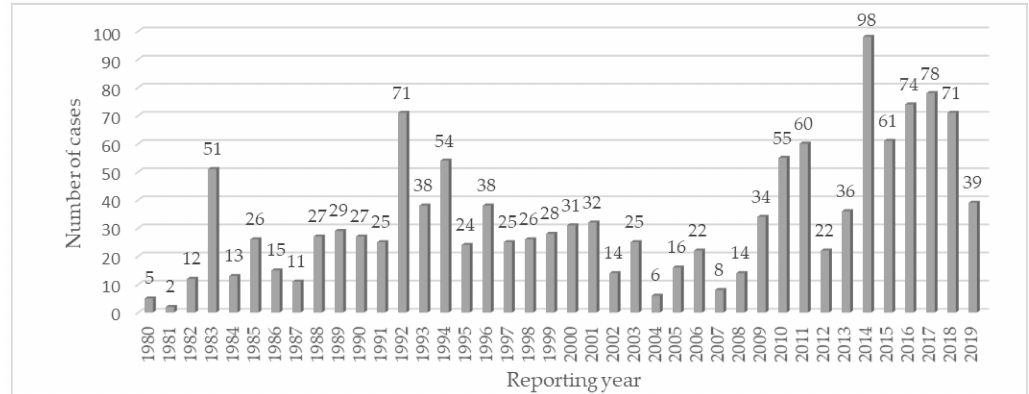
Figure 1. Time trend of individual case safety report in the Hepatobiliary System Organ Class cases for second-generation cephalosporins .